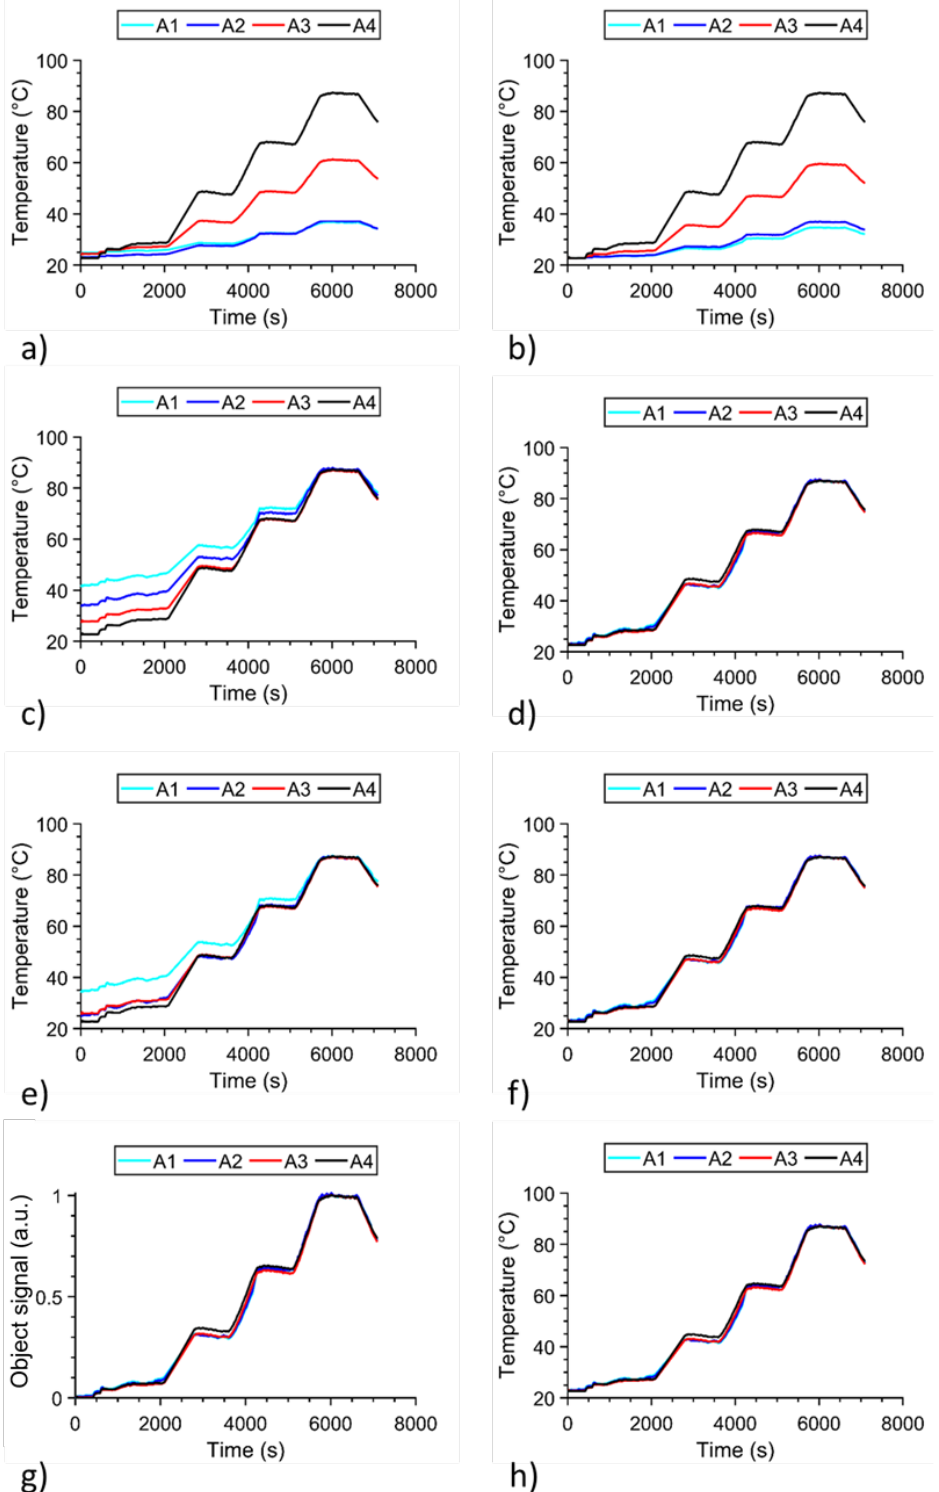
Figure 7. Measurement result for FLIR A615 (LWIR): ( a ) raw data (whole image emissivity 0.92), ( b ) raw data − 1st image + Tinit (emissivity 0.92), ( c ) emissivity correction method 1 of ( a ), ( d ) emissivity correction method 1 of ( b ), ( e ) emissivity correction method 2 of ( a ), ( f ) v correction method 2 of ( b ), ( g ) emissivity correction method 3 in OS, ( h ) emissivity correction method 3 in °C.